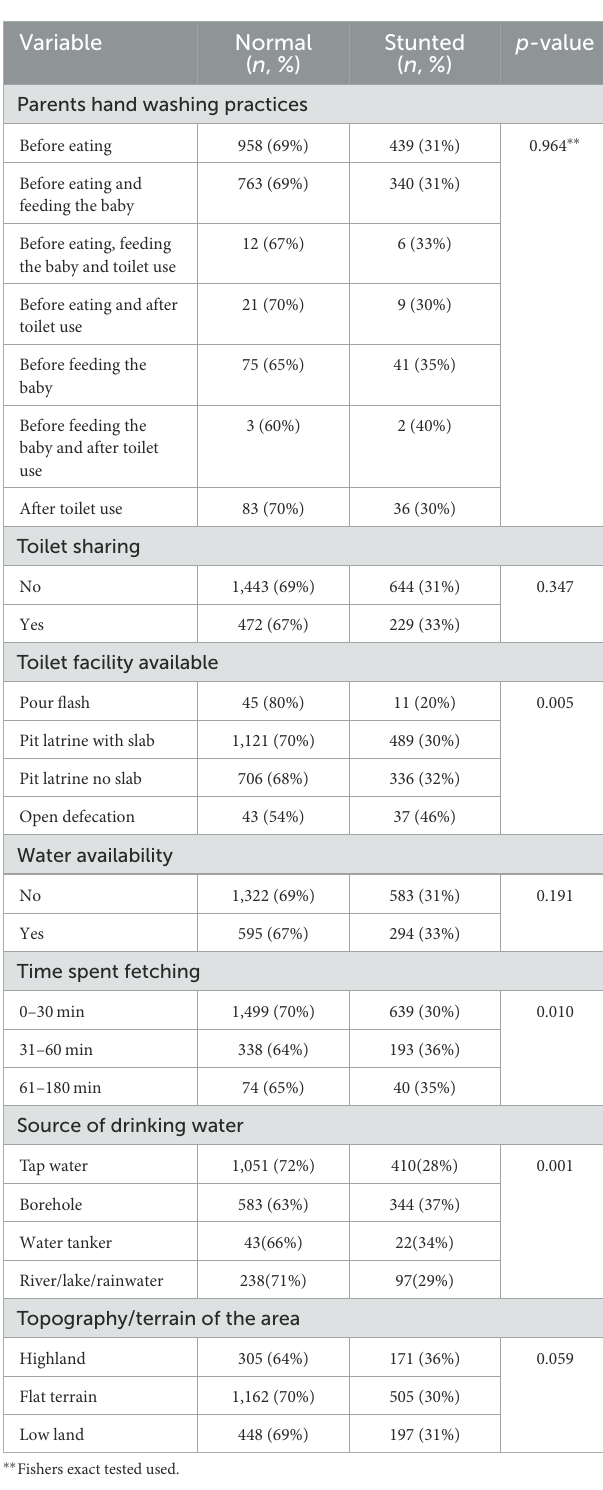
TABLE 2 Prevalence of childhood stunting at various environmental and factors, female children were about 76% (aOR: 0.76, 95% CI: WASH characteristics. 0.64–0.90) less likely to be stunted compared to male children. p- value Variable Normal Stunted ( n , %) ( n , %)